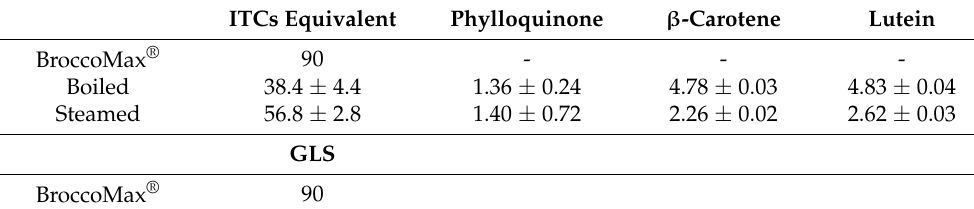
Table 1. Amount (mg) of some bioactive compound given to volunteers by consuming 400 g of cooked broccoli (boiled and steamed) and total GLS administered by taking 3 capsules of BroccoMax ® . Data are expressed as mean ± SD of five cooking replicates. Level of GLS in BroccoMax ® is as stated on the label by the manufacturer.